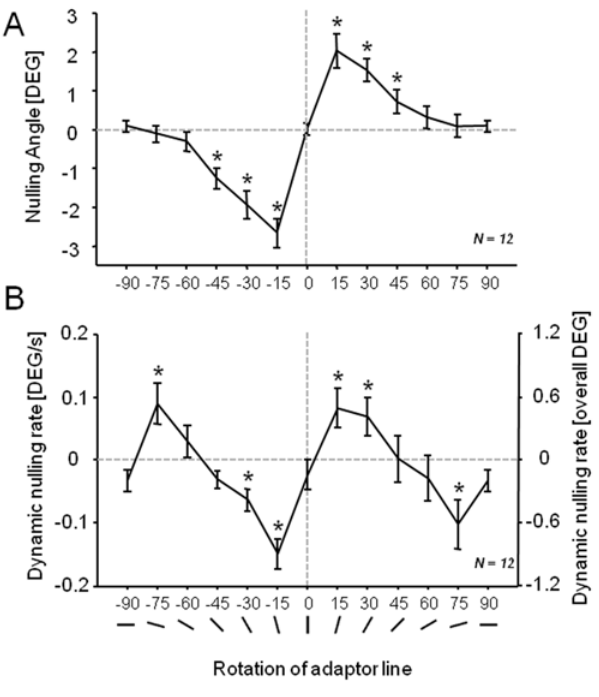
Figure 3. Aftereffect and adaptation with oriented line segments. A. The static nulling probe revealed that adaptation near 6 15 u led to the strongest aftereffect, in agreement with many previous studies. B. Adaptation to the dynamic nulling stimulus similarly revealed peaks 6 15 u from the vertical stimulus, as well as peaks at 6 75 u , corresponding to 6 15 u from the horizontal stimuli. Data points show average values over 12 subjects, the same individuals in A and B. Error bars represent standard error of the mean between subjects (s.e.m.). Data points marked by an asterisk (*) are significantly different from zero (2-sided t-test, p , .05, not corrected).